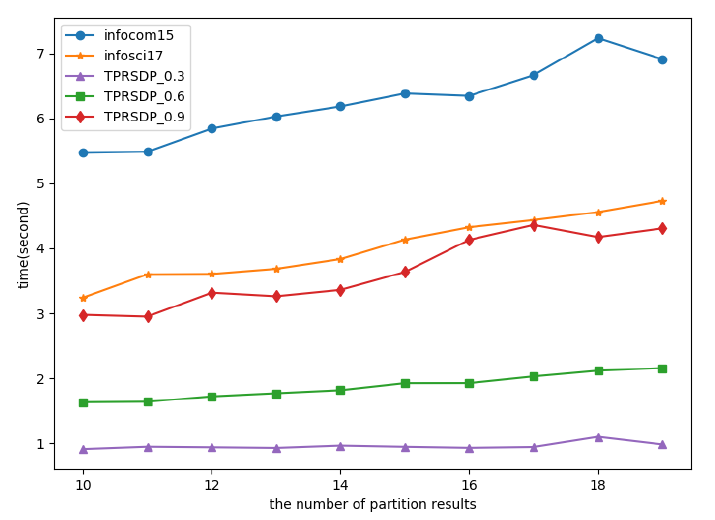
Figure 2. Time cost (Geolife